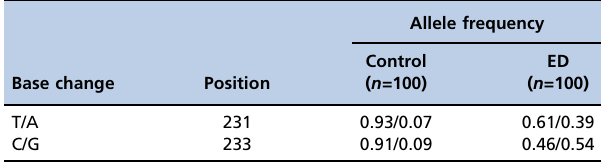
Table S5 - SNP in the miR-195-5p-binding region of DRD1 3 0 -